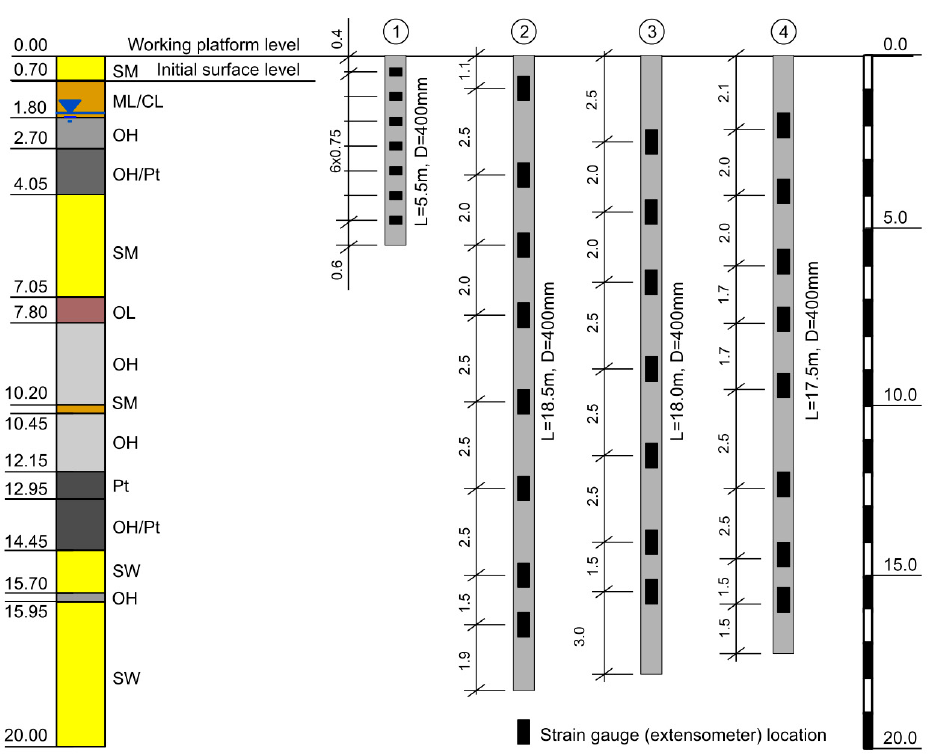
Figure 10. Instrumented piles schemes and corresponding soil profile on testing field.